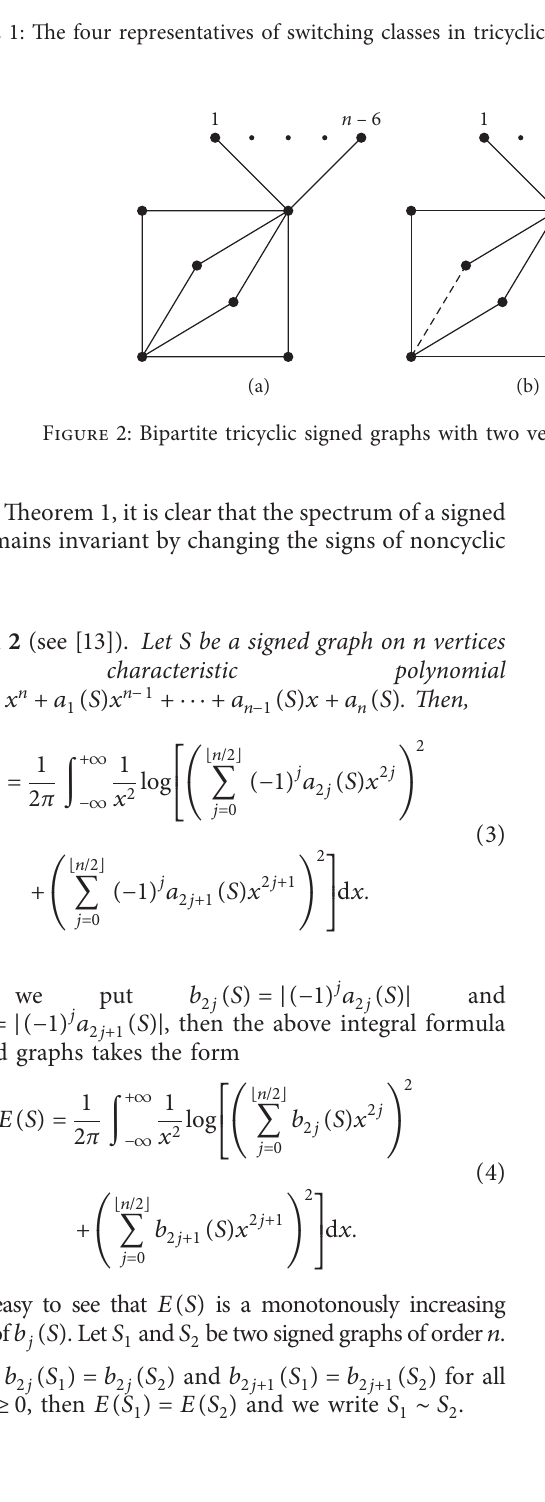
S 1 S 2 S 3 S 4 n,n + 2 . (a) n,n + 2 . (b) n,n + 2 . (c) n,n + 2 . (d) n,n + 2 .